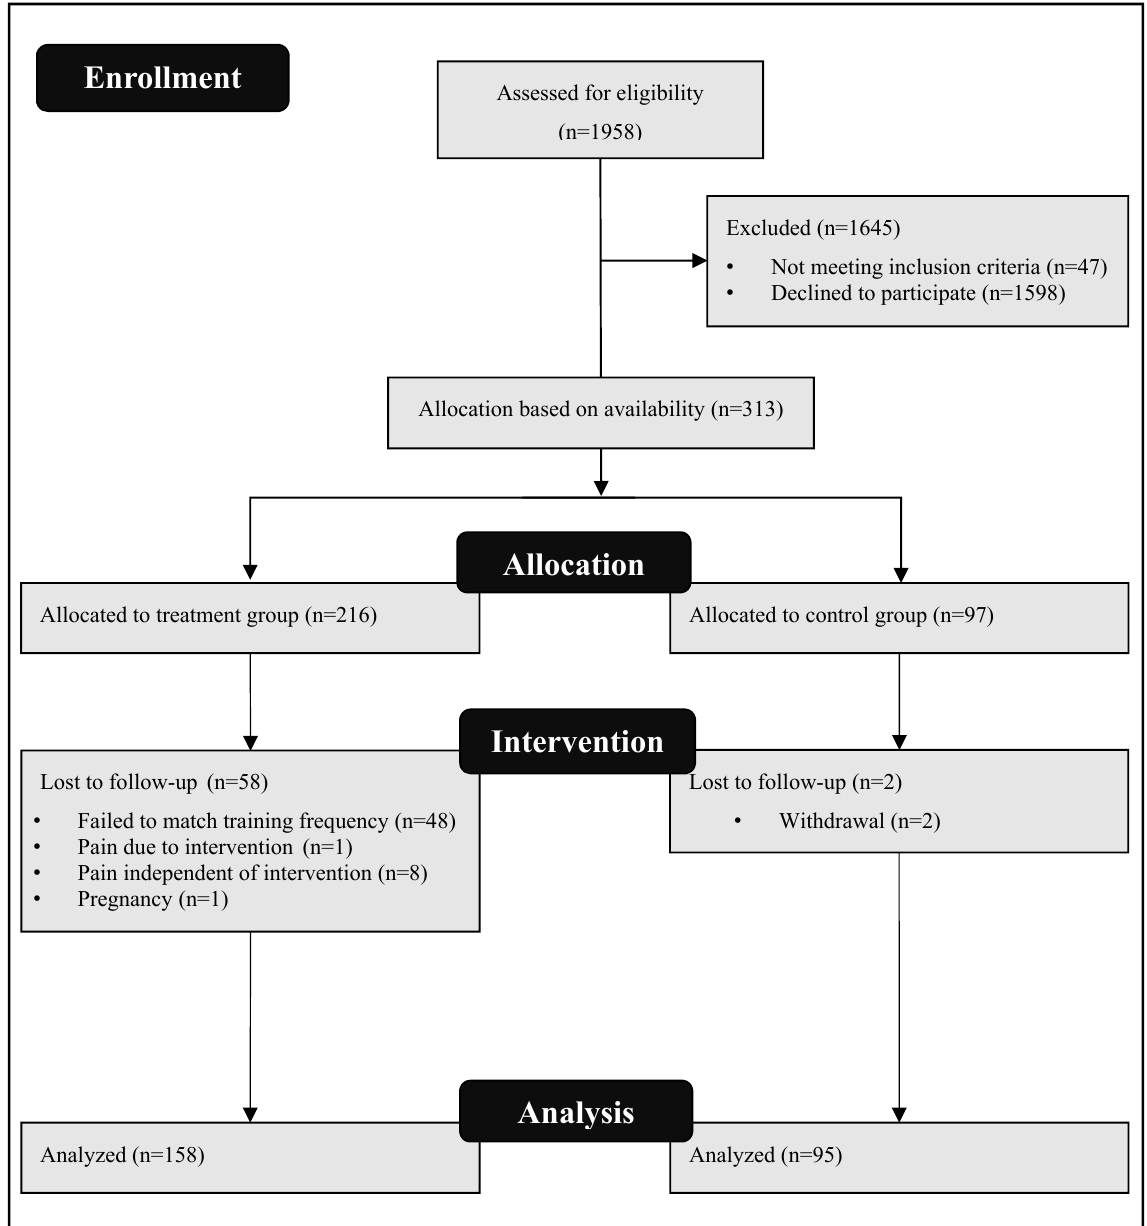
Figure 1. Disposition of study participants.